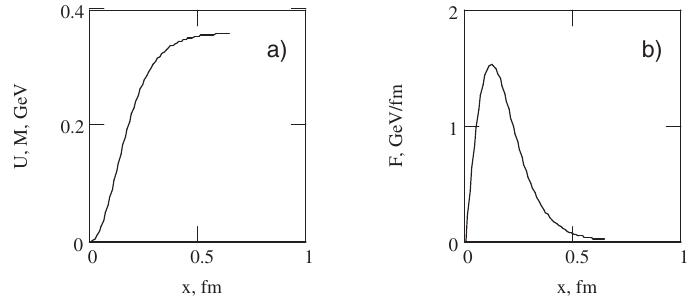
Figure 3. a) Potential energy of a quark and its dynamical (constituent) mass versus its displacement from the origin of oscillation; b) ”Confinement”